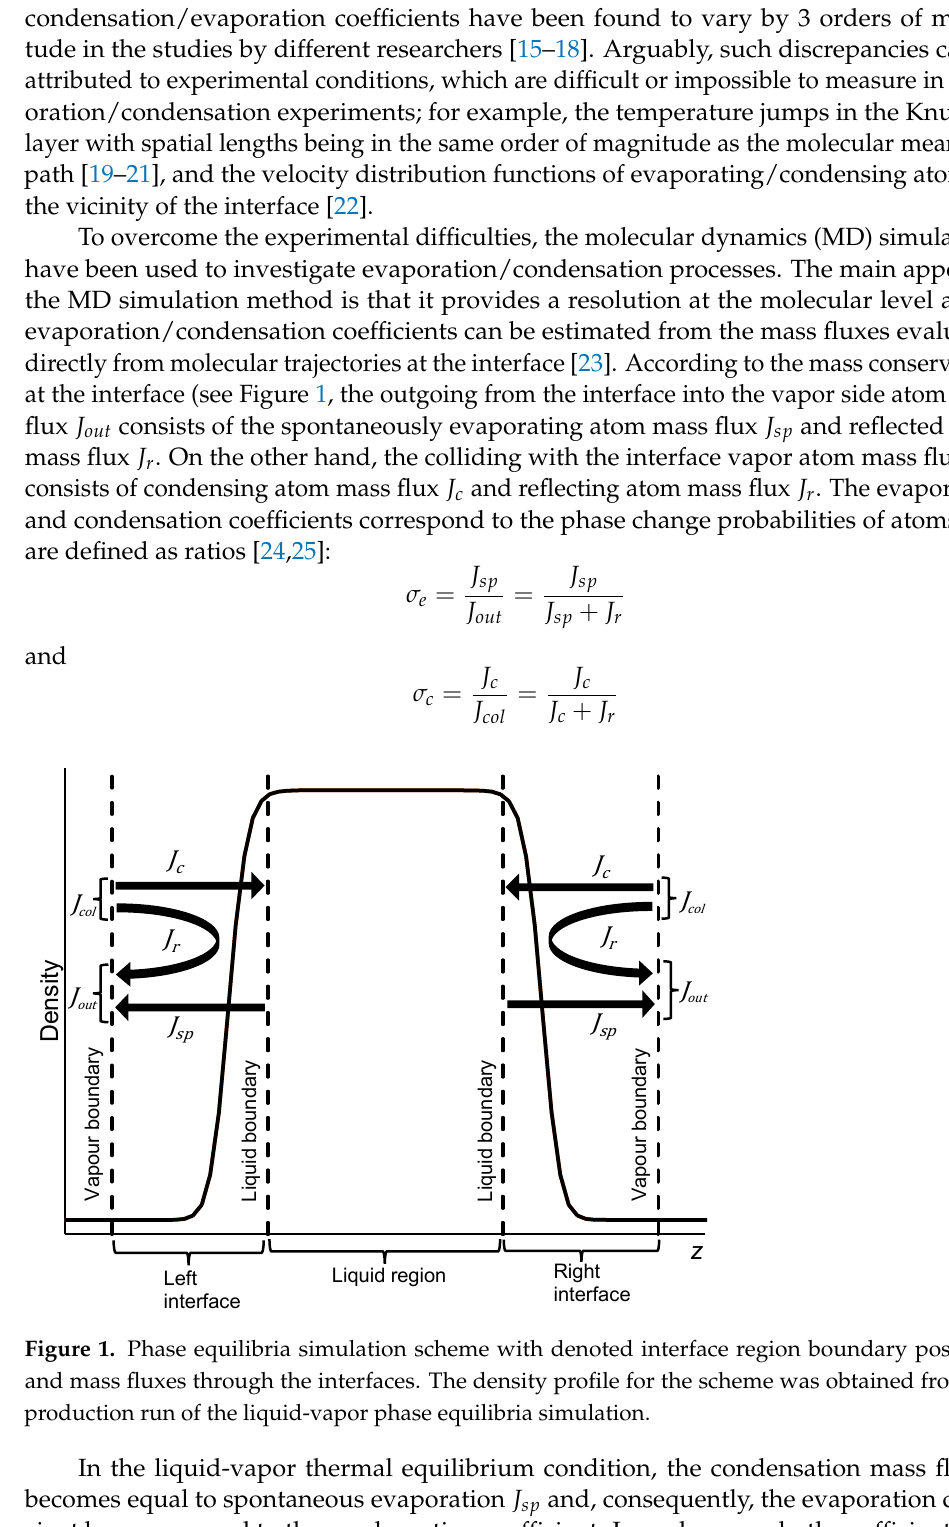
Figure 2. Phase equilibria simulation snapshot at a random moment of time. The periodic boundary conditions are applied to x , y and z axes. The positions of the liquid and vapor boundaries were set in terms of the density profile obtained from the production run of the equilibria simulation as shown in Figure 1. The simulation data shows that the density continuously decreases from the liquid phase density to the vapor phase density in the left- and right-side transition regions of the phase equilibria simulation density profile. The transition region density can be well approximated by a hyperbolic tangent function for the left-side interface [29]: 𝜌 (cid:3039)(cid:3032) (cid:4666)𝑧(cid:4667) = 1 2 (cid:4666)𝜌 (cid:3049) + 𝜌 (cid:3039) (cid:4667) − 1 2 (cid:4666)𝜌 (cid:3049) − 𝜌 (cid:3039) (cid:4667)𝑡𝑎𝑛ℎ (cid:3436)𝑧 − 𝑧 (cid:2868),(cid:3039)(cid:3042)(cid:3050) 𝛿 (cid:3039)(cid:3042)(cid:3050) (cid:3440) (3) and for the right-side interface: 𝜌 (cid:3045)(cid:3036) (cid:4666)𝑧(cid:4667) = 1 2 (cid:4666)𝜌 (cid:3049) + 𝜌 (cid:3039) (cid:4667) + 1 2 (cid:4666)𝜌 (cid:3049) − 𝜌 (cid:3039) (cid:4667)𝑡𝑎𝑛ℎ (cid:4678)𝑧 − 𝑧 (cid:2868),(cid:3048)(cid:3043) 𝛿 (cid:3048)(cid:3043) (cid:4679) (4)